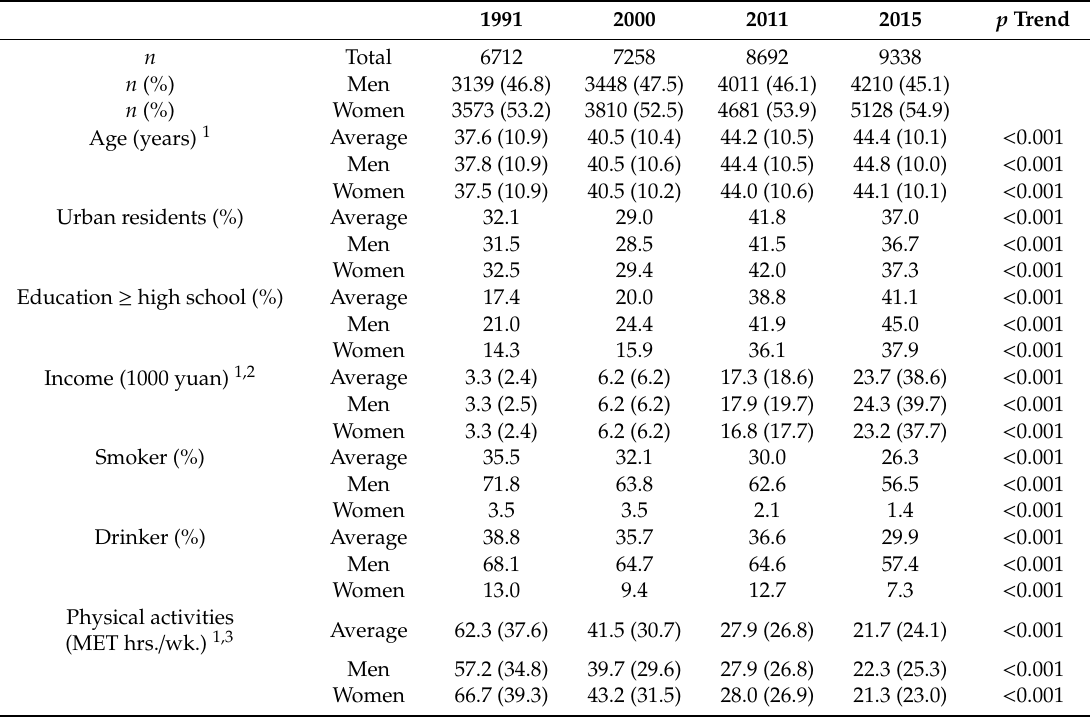
Table 1. Sample characteristics of the China Health and Nutriton Survey, 1991–2015.